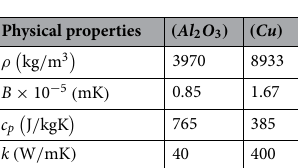
Table 1. Numerical values of thermophysical properties of nanoparticles and pure fluid 26 .